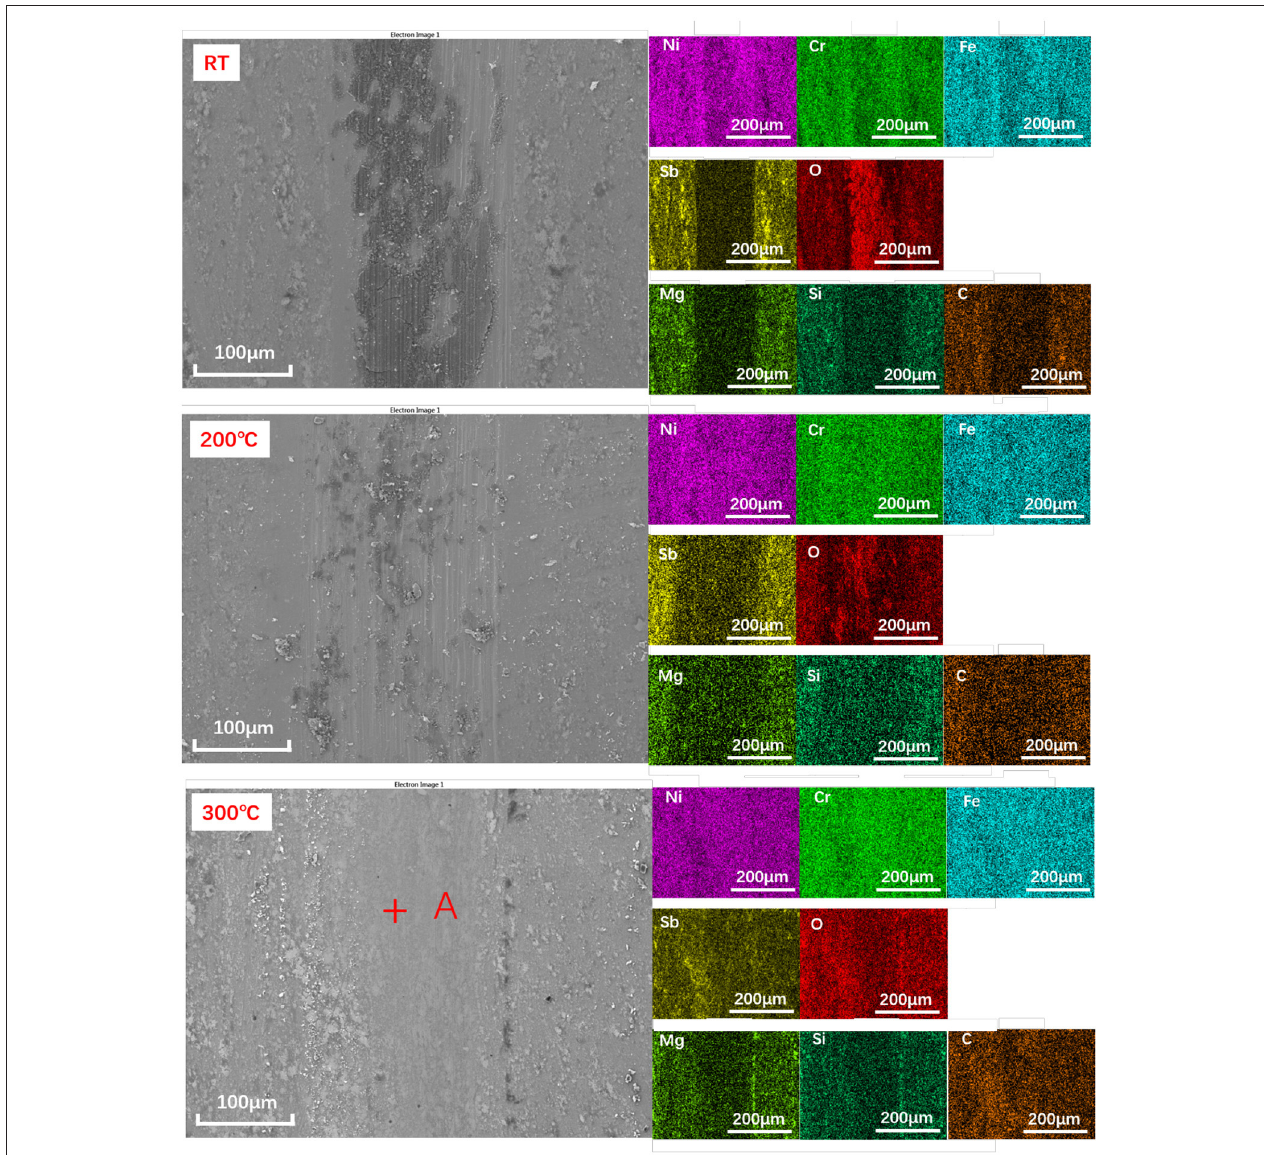
FIGURE 6 | The SEM and EDS elemental mapping images of the Sb 2 O 3 -MSH/C wear track areas formed during the tribotests performed under different temperature conditions. Point A was selected for the XPS